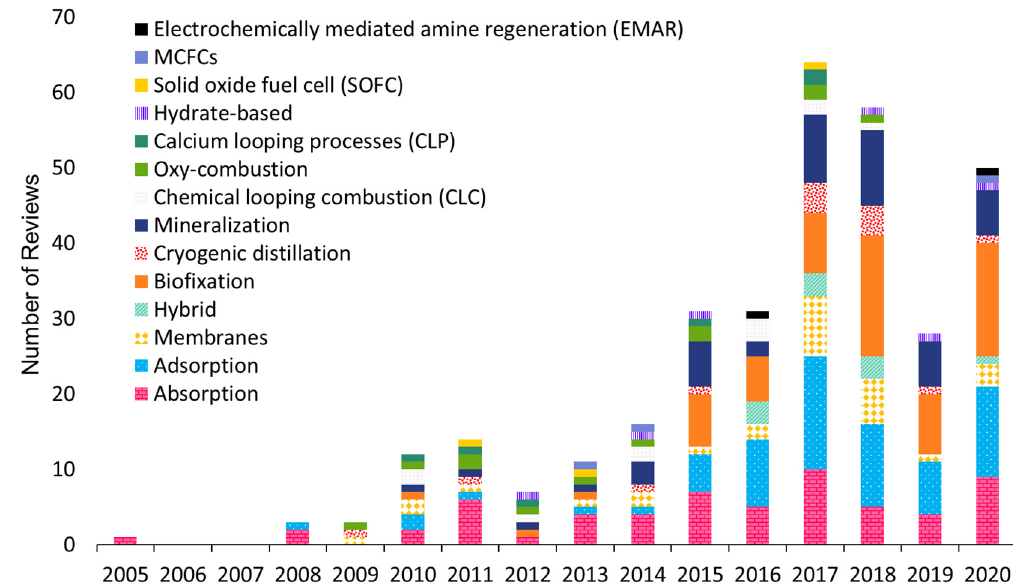
Figure 15. Annual citation frequency distribution of CO 2 capture and separation techniques in review papers.